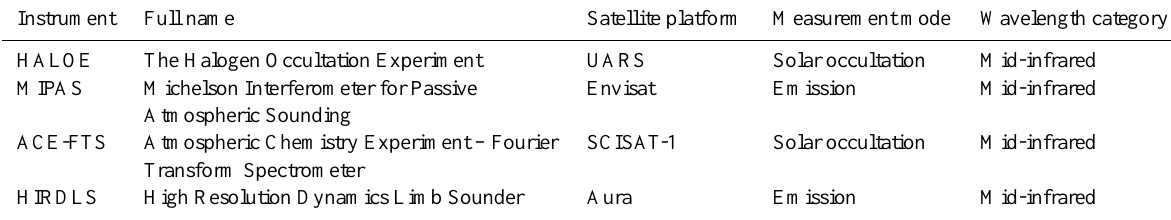
Table 1. Full instrument name, satellite platform, measurement mode, and wavelength category of all instruments included in this study given in order of satellite launch